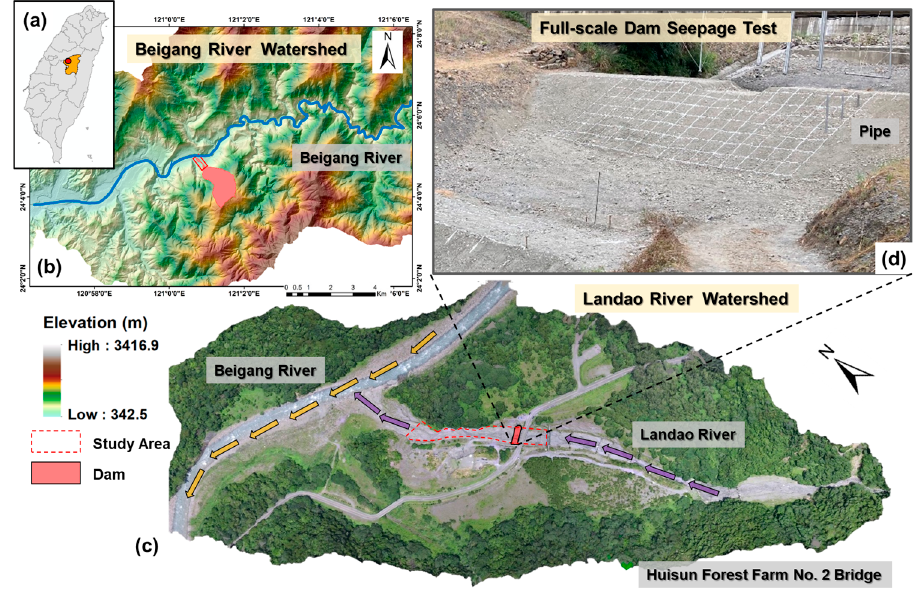
Figure 9. Study area: ( a ) Guoxing Township, Nantou County; ( b ) Beigang River watershed; ( c ) Lanjiang River watershed; ( d ) deposition condition of on-site earth dam.